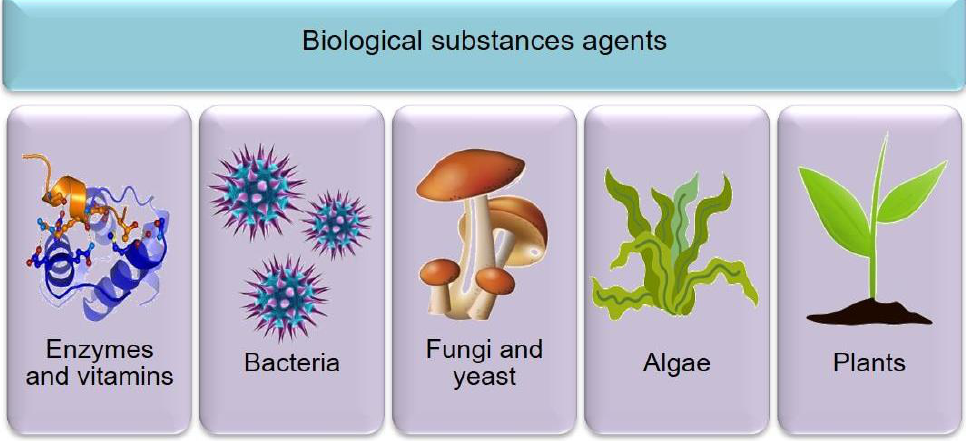
Figure 8. Green synthesis of low dimensional materials via enzymes, vitamins, bacteria, fungi and yeast, algae, and plants as the possible reduction, capping, stabilizer, and exfoliation agents.